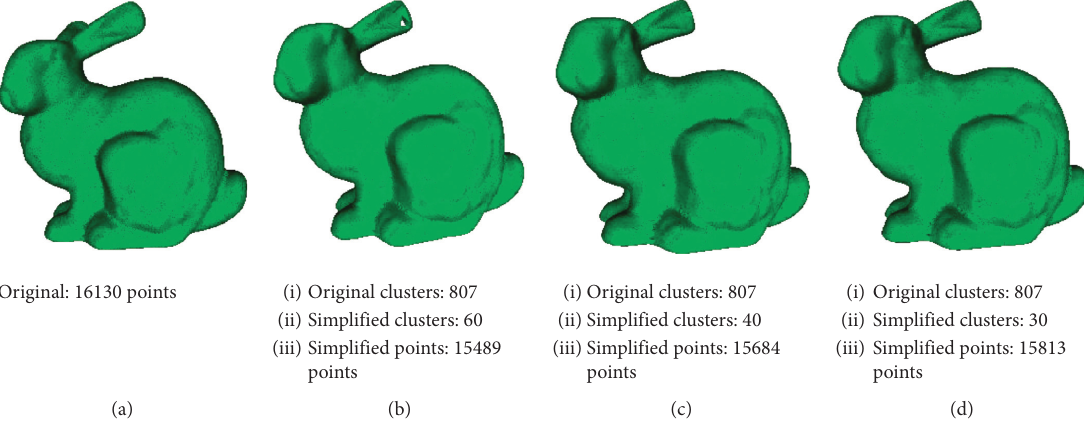
Figure 7: Simplification of the bunny model at different levels of detail (triangulated).